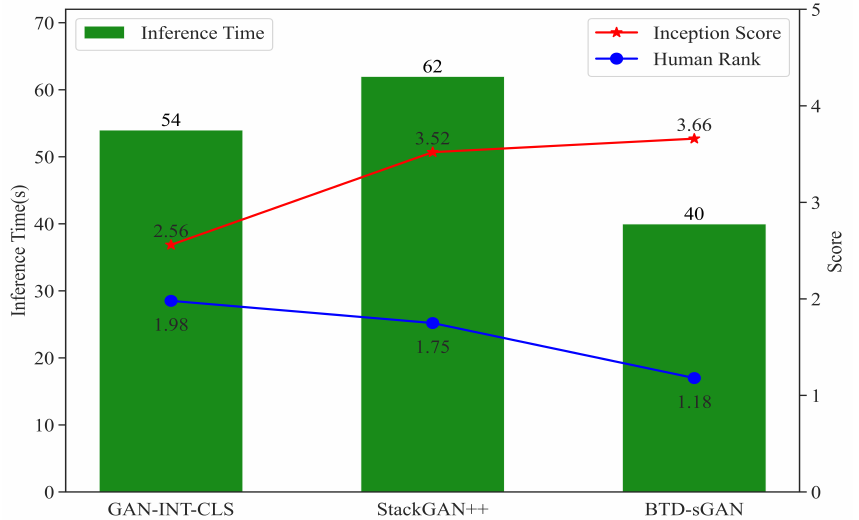
Figure 11. The performance comparison of different